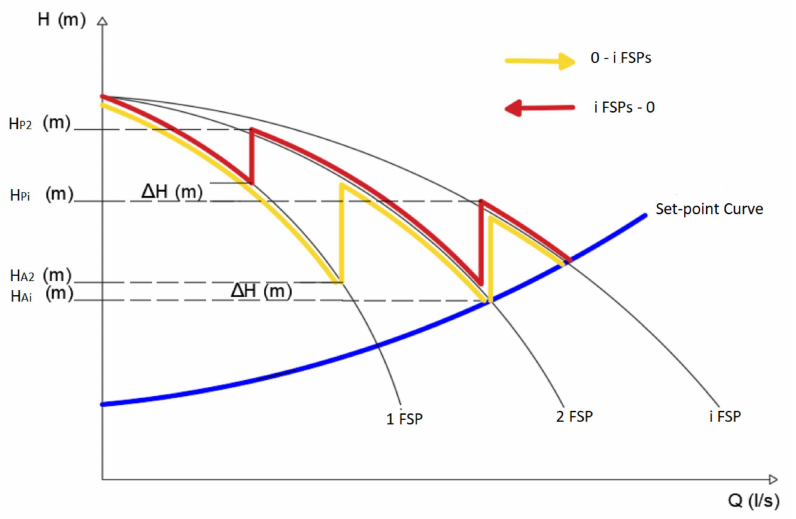
Figure A1. Pressure control with FSPs regulation